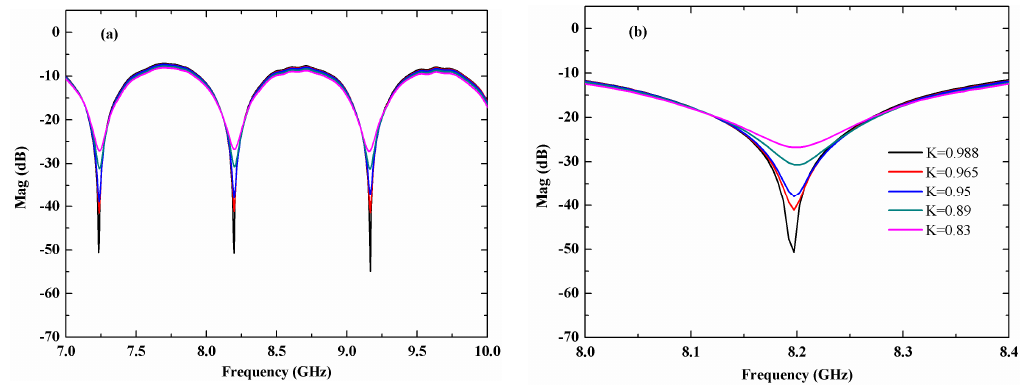
Figure 7. ( a ) Microwave response function at different dynamic ranges, ( b ) The detail of the valley